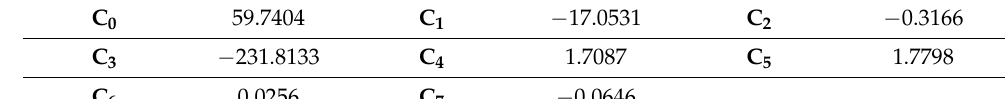
Table 4. Seven coefficients and one constant (for seven input variables corresponding to the physicochemical properties of C 3 S and solvents) optimized for the analytical model of the generic solvent scenario.